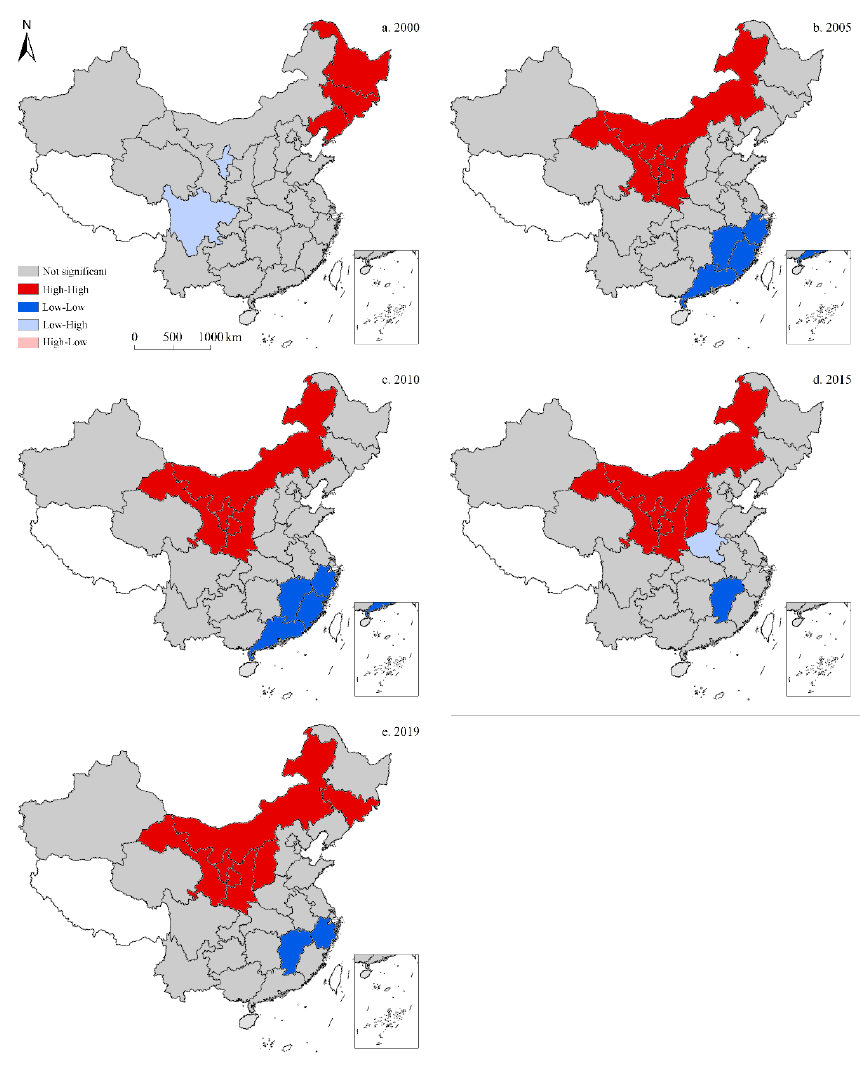
Figure 12. LISA map for the provincial-level spatiotemporal distribution of CO 2 emissions per unit GDP in China (five-time sections).